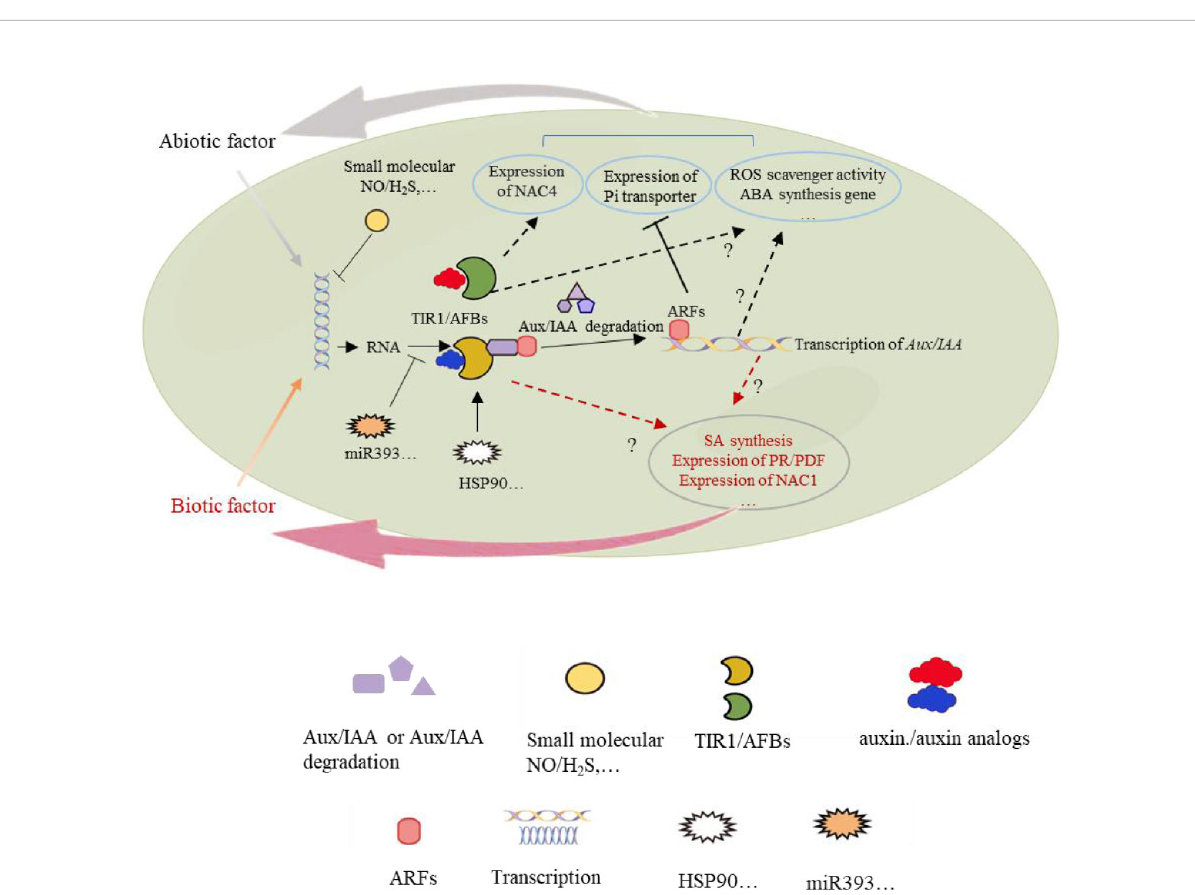
FIGURE 3 TIR1/AFB regulatory network in response to abiotic and biotic stress. TIR1/AFBs response to abiotic or biotic factors in different signal transduction